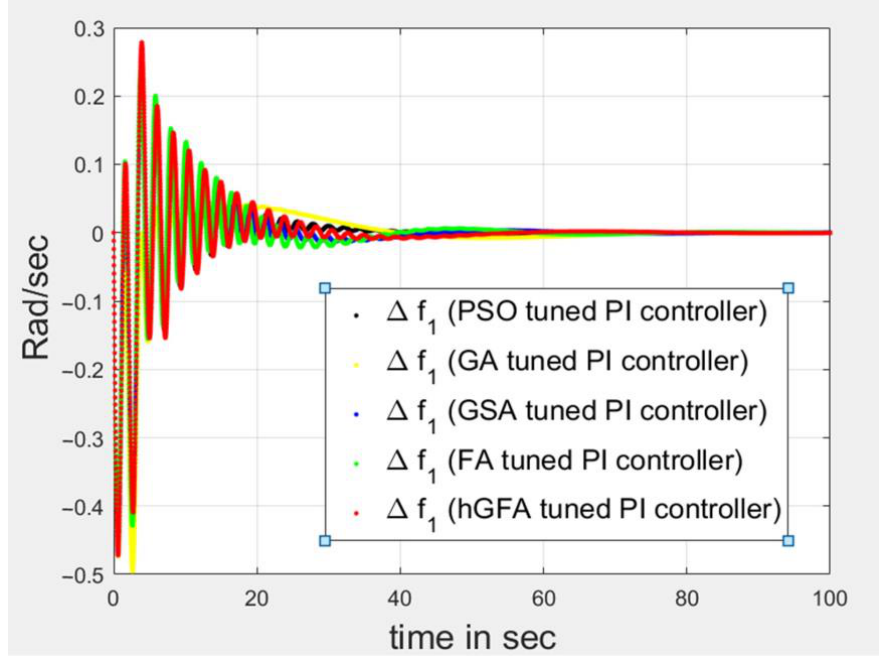
Figure 2. Perturbation in load frequency response in area-1 of HTPS for case study-I.